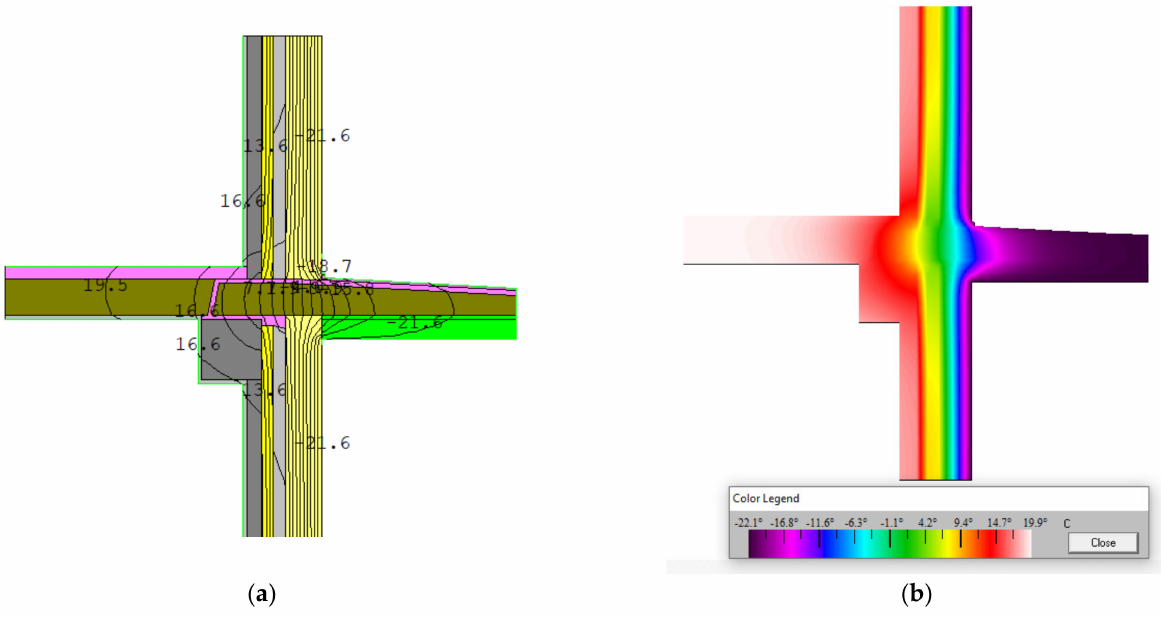
Figure 7. Temperature field in cross-section for scenario II B, wall with 15 cm thick insulation: ( a ) isotherms ( b ) colour